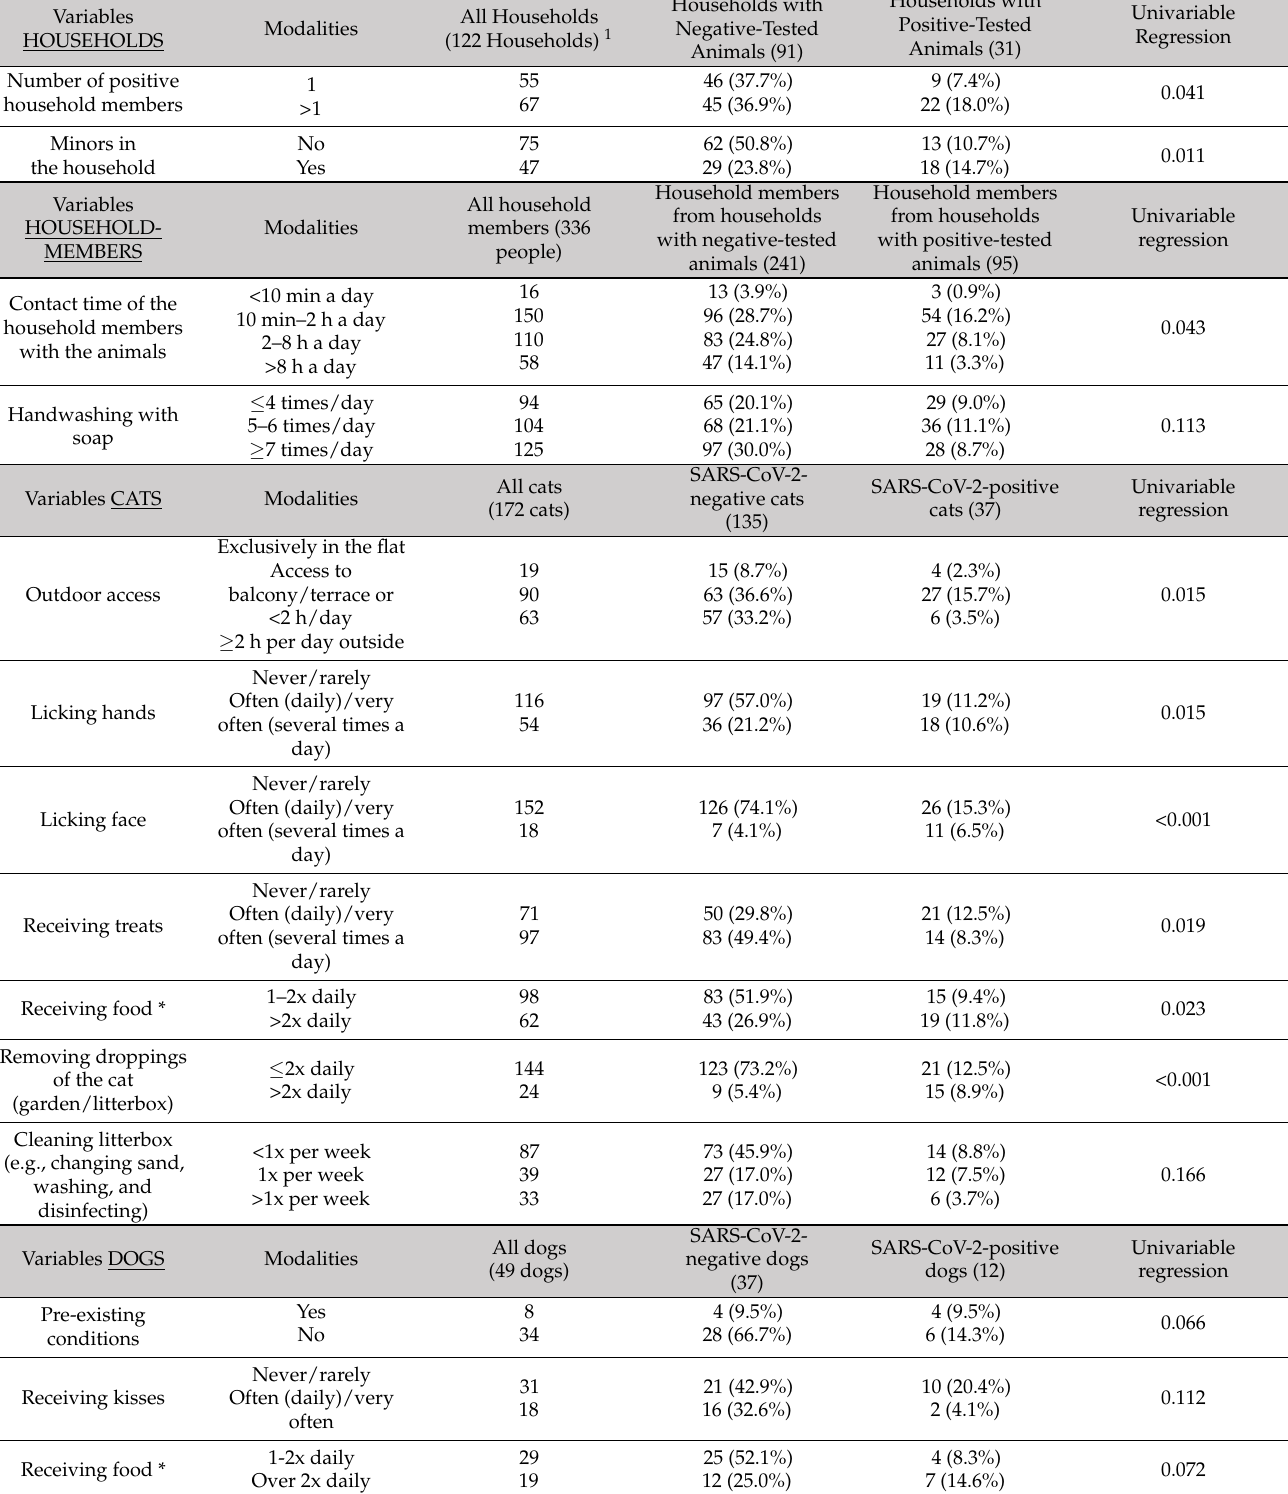
Table 3. Variables with a p -value < 0.2 in the univariable binary logistic regression